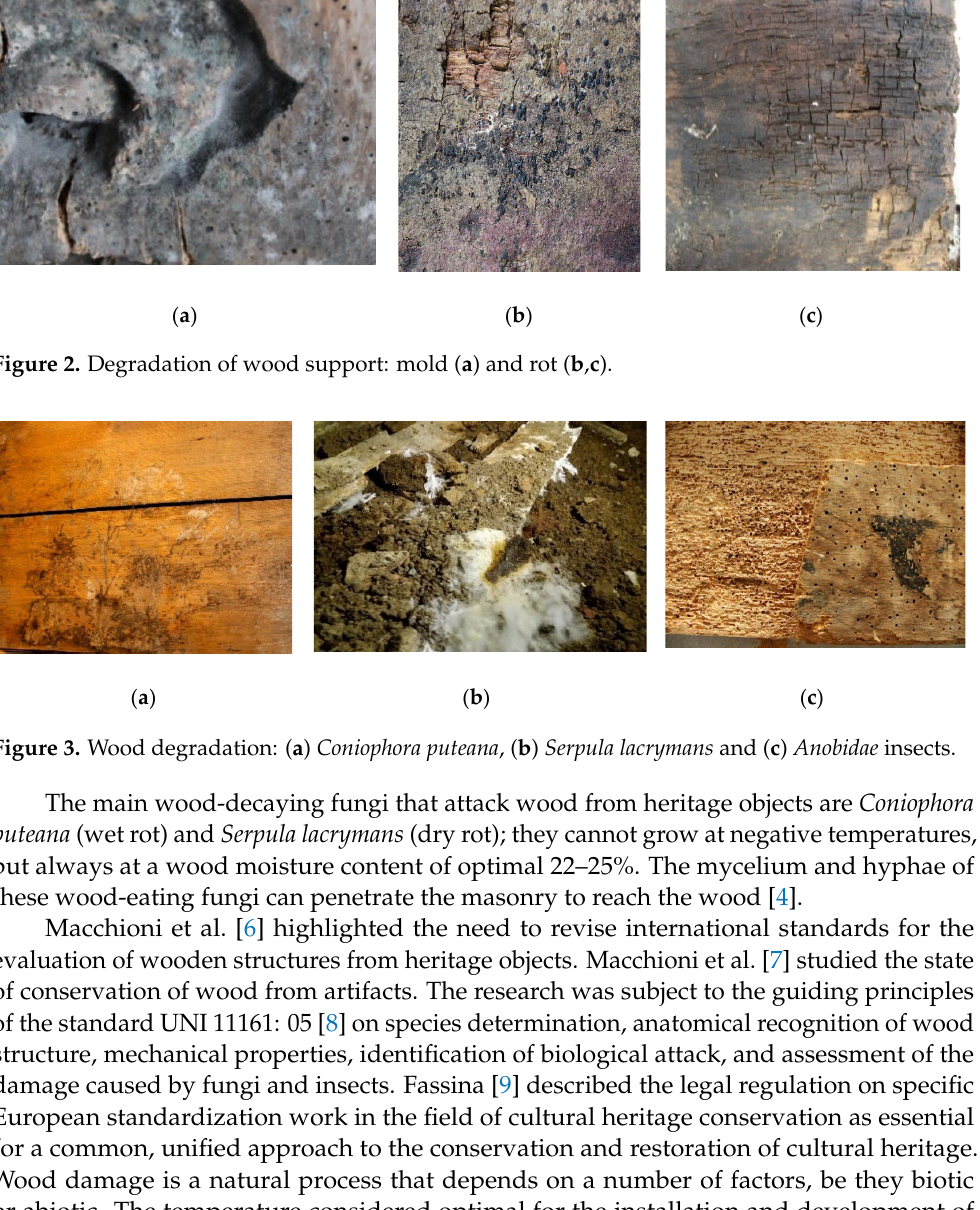
Figure 3. Wood degradation: ( a ) Coniophora puteana , ( b ) Serpula lacrymans and ( c ) Anobidae insects.